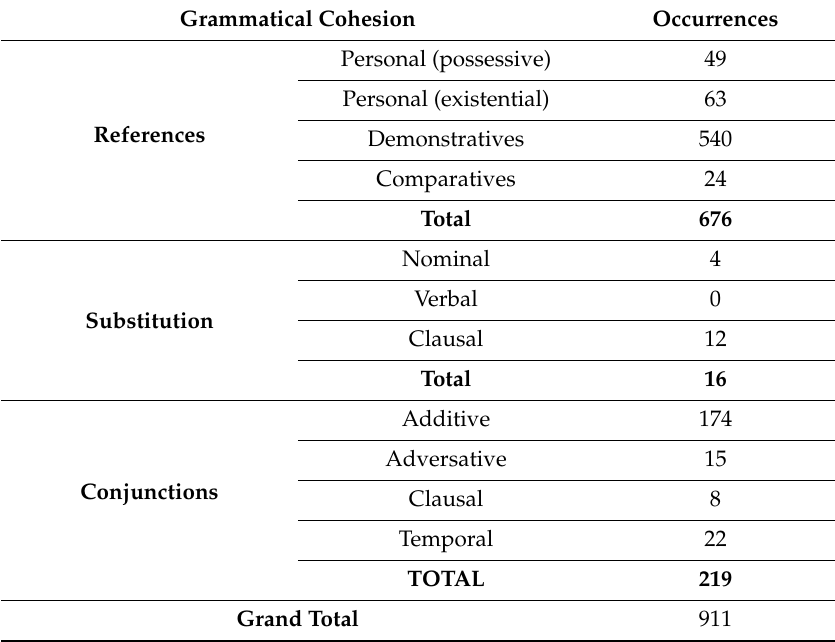
Table 4. Grammatical